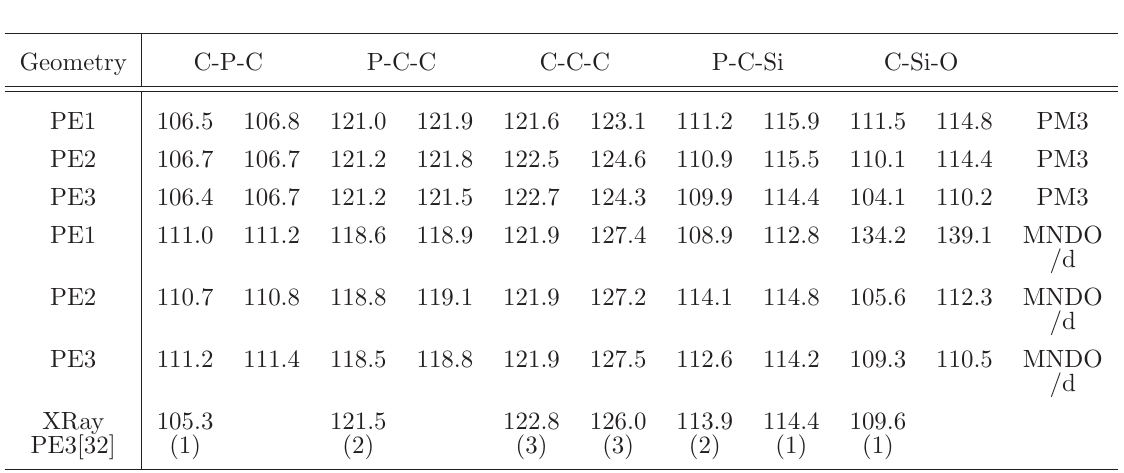
Table 2 Valence angles of phosphinine-eter macrocycles resulted from PM3 and MNDO/d cal- culation (deg) [41, 42].